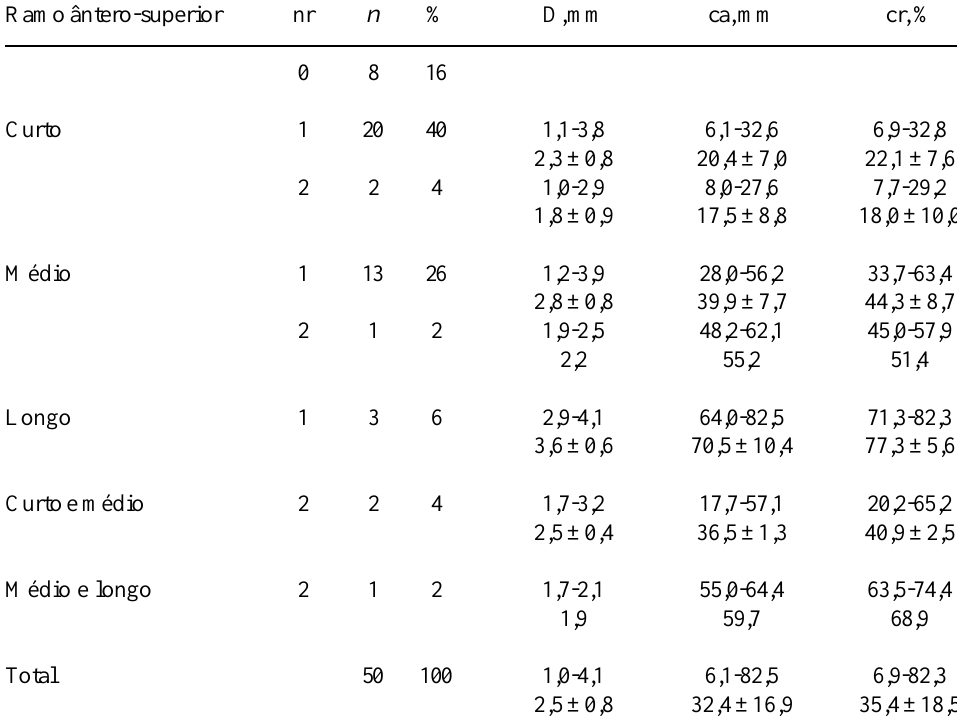
Tabela 2. Distribuição da freqüência, do número de ramos, do diâmetro e dos comprimentos absoluto e relativo do ramo ântero-superior, conforme o